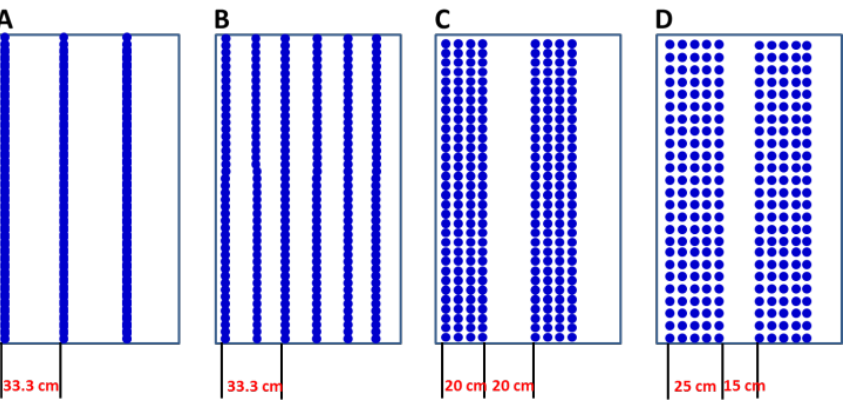
Figure 2. The four sowing patterns ( A ): Line and dense sowing with wide (33.3 cm) row space (LDW). ( B ): Line and dense sowing with narrow (16.6 cm) row space (LDN). ( C ): belt uniform sowing with wide (20 cm) row space (BUN). ( D ): belt uniform sowing with narrow (15 cm) row space (BUW) used in this study. All sowing patterns have the same seed rate.